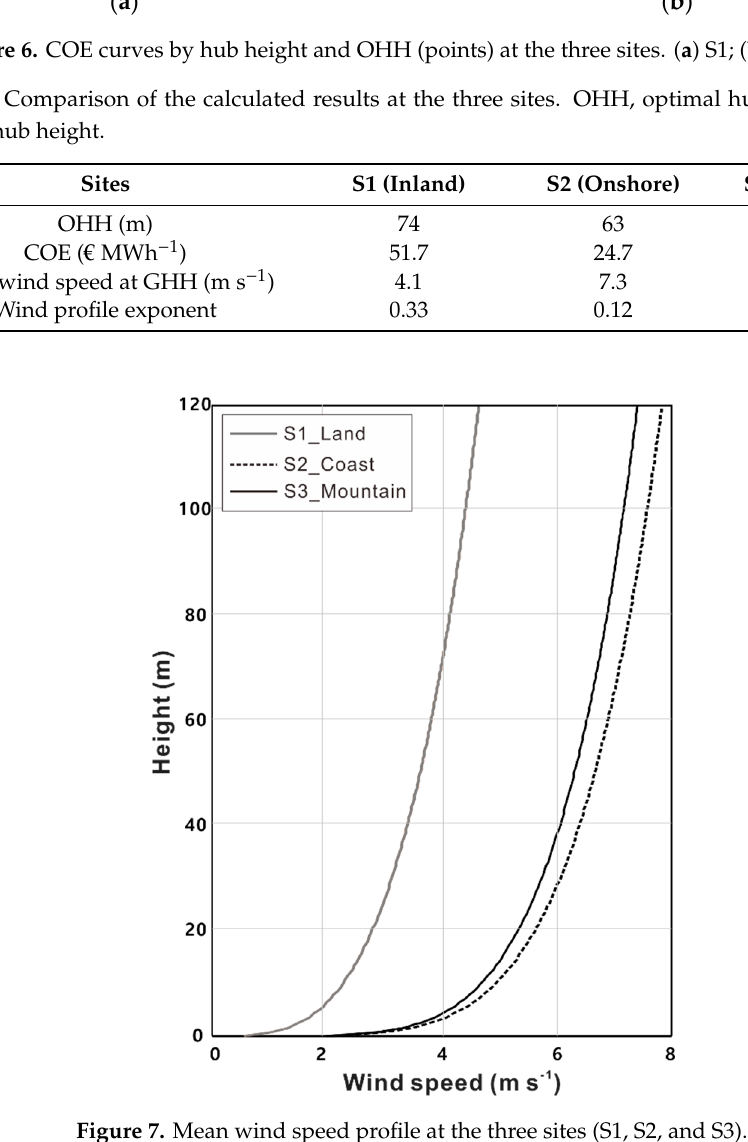
Figure 7. Mean wind speed profile at the three sites (S1, S2, and S3).